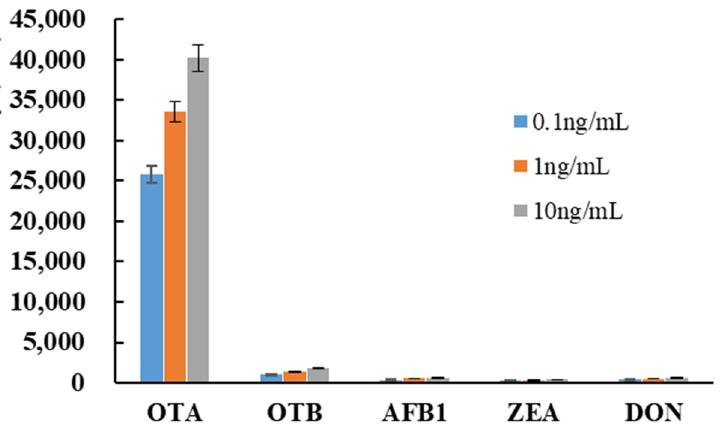
Figure 5. The specificity of the OTA aptamer-based ACSB system in detecting OTA. Four mycotoxins, namely, OTB, AFB 1 , ZEA, and DON, at 0.1 ng/mL, 1 ng/mL, or 10 ng/mL were used to determine